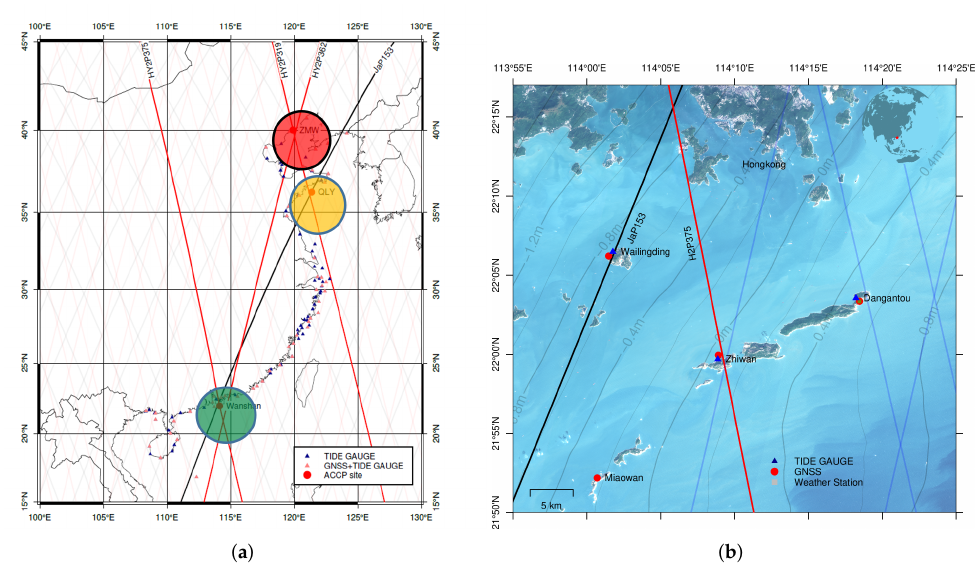
Figure 5. ( a ) Distribution of key facilities of the ground infrastructure of the Altimetry Calibration Cooperation Plan of China along with the National Oceanic Observation Stations at Qianliyan (QLY) at Qingdao, Zhimaowan (ZMW) at Bohai Sea and at Whanshan islands, south of Hong Kong, and ( b ) the dedicated Wanshan of three small islands (Dangantou, Zhiwan and Wai Lingding) with Cal/Val sites for HY-2 satellite altimeter. HY-2B orbit No.375 is an ascending orbit. Orbit No.362 is a descending